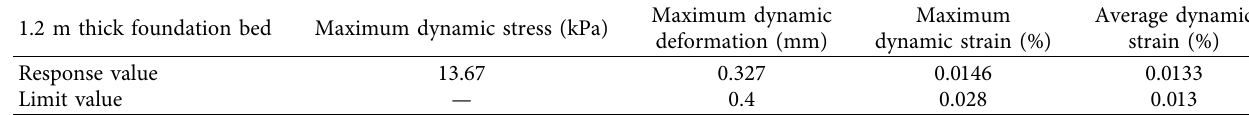
Table 7: Dynamic response results of the 1.2m thick foundation bed.